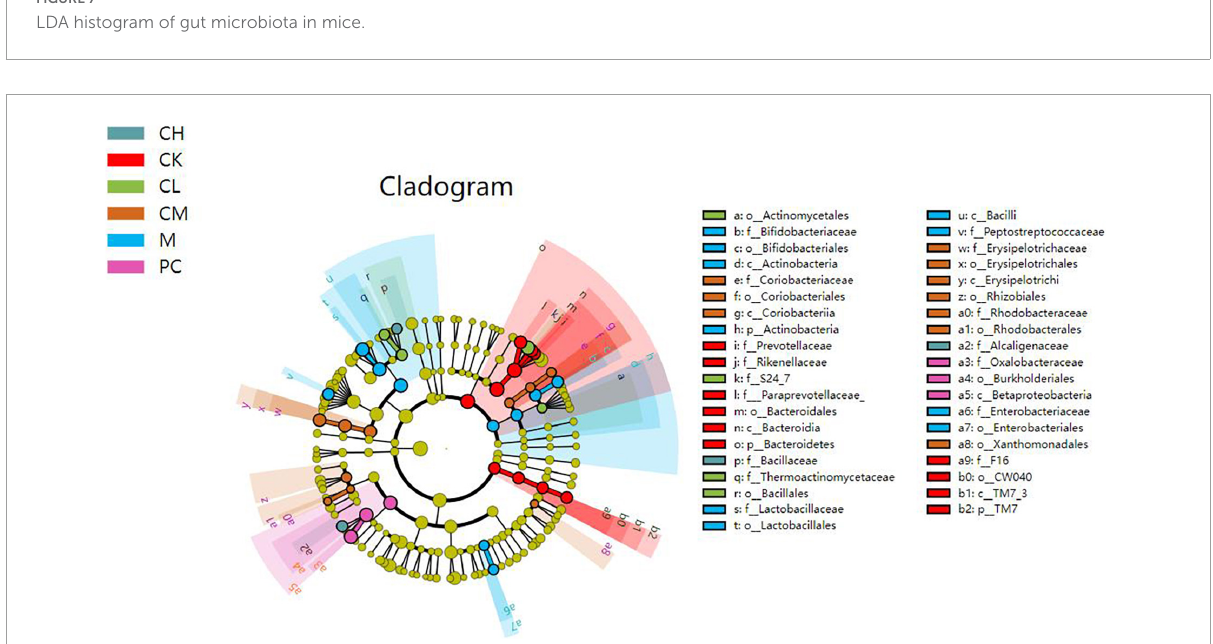
FIGURE8 Cladogram graph of gut microbiota in